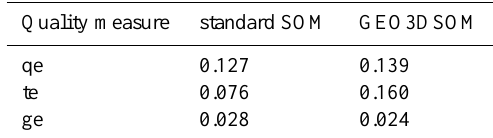
Table 5. Quality measures for the hydrochemical data set. Quality measure standard